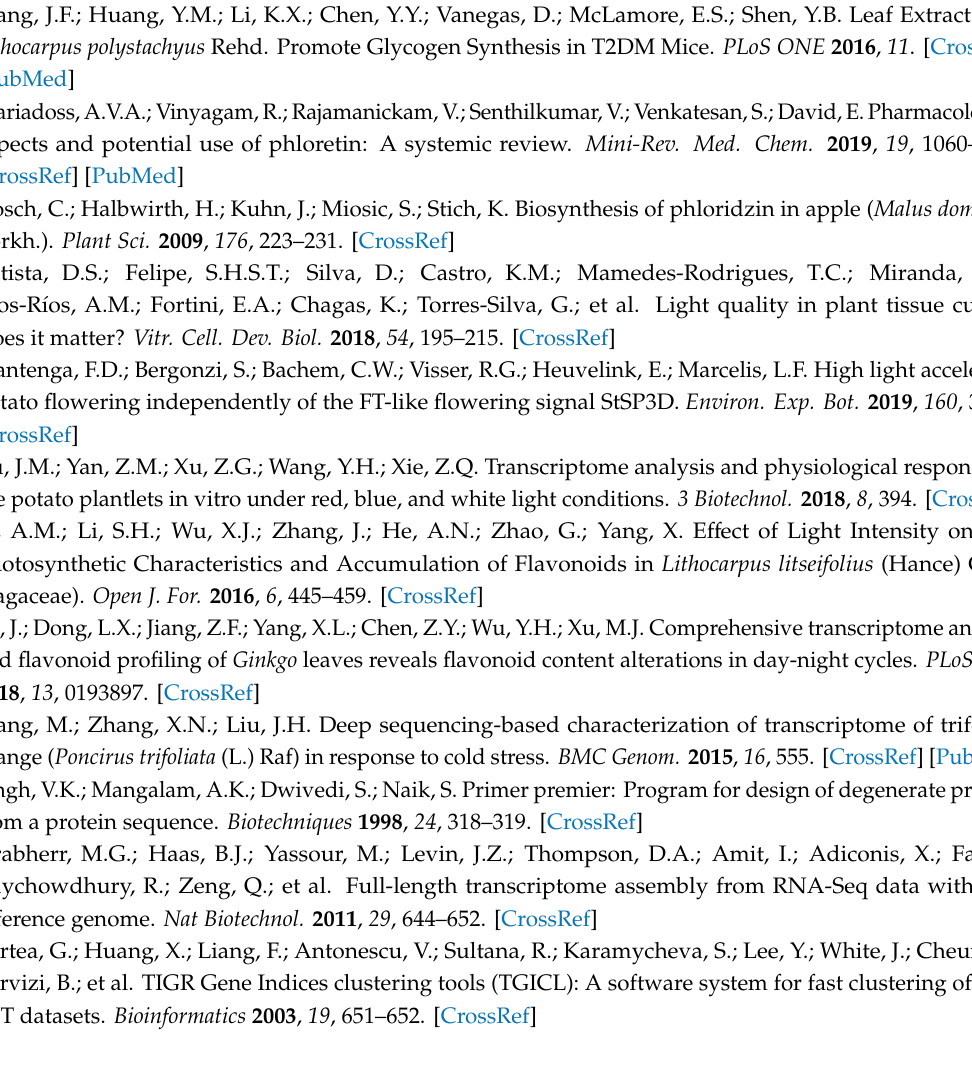
Figure S1: NR database sequence alignment result graph, Figure S2: GO enrichment results of di ff erentially expressed genes, Figure S3: Di ff erentially expressed genes (DEGs) in di ff erent treatment groups, Table S1: unigenes function annotation statistics, Table S2: KEGG database annotation statistics, Table S3: Annotation information for genes di ff erentially expressed in all treatment groups, Table S4: DEGs statistics of the treatment groups in the light quality treatment type, Table S5: DEGs statistics of the processing group in the photoperiod processing type, Table S6: DEGs statistics of the treatment group in the light intensity treatment type, Table S7: Statistics on the number of di ff erentially expressed transcription factors, Table S8: Di ff erentially expressed genes encoding MYB transcription factors, Table S9: Di ff erentially expressed genes encoding BHLH transcription